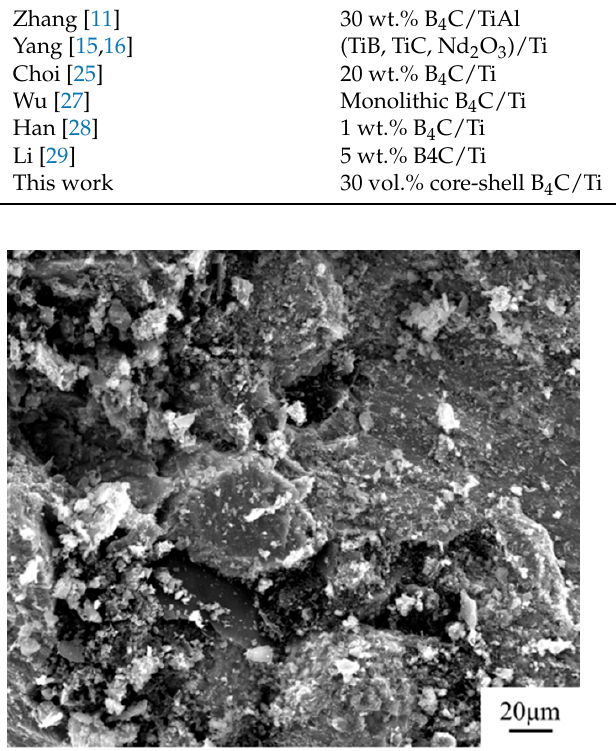
Figure 10. Fractured surface morphology of B 4 C/Ti composites with core-shell structure. In addition, the hardness, thermal conductivity and electric conductivity of the B 4 C/Ti composites were tested, and the results are shown in Table 2. The hardness of the B4C/Ti composites reached a high level (697.89 HV), which indicates that the B 4 C reinforcement has a more favorable strengthening effect. At the same time, due to the influence of